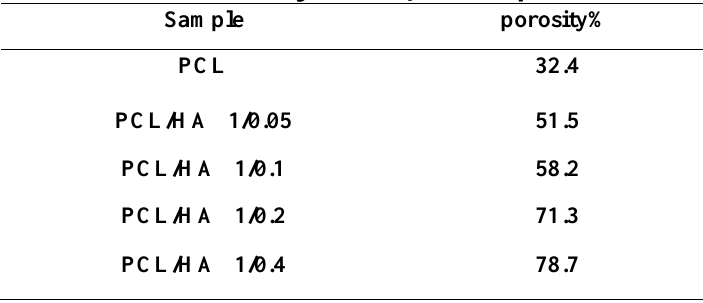
Table 1: Porosity of PCL/HA